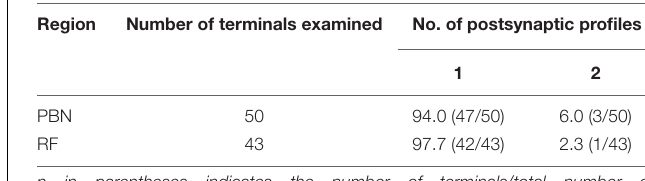
TABLE 1 | Frequency (%) of occurrence of terminals of the rostral nucleus of the solitary tract (rNST) neurons in the parabrachial nucleus (PBN) and medullary reticular formation (RF), according to the number of their postsynaptic